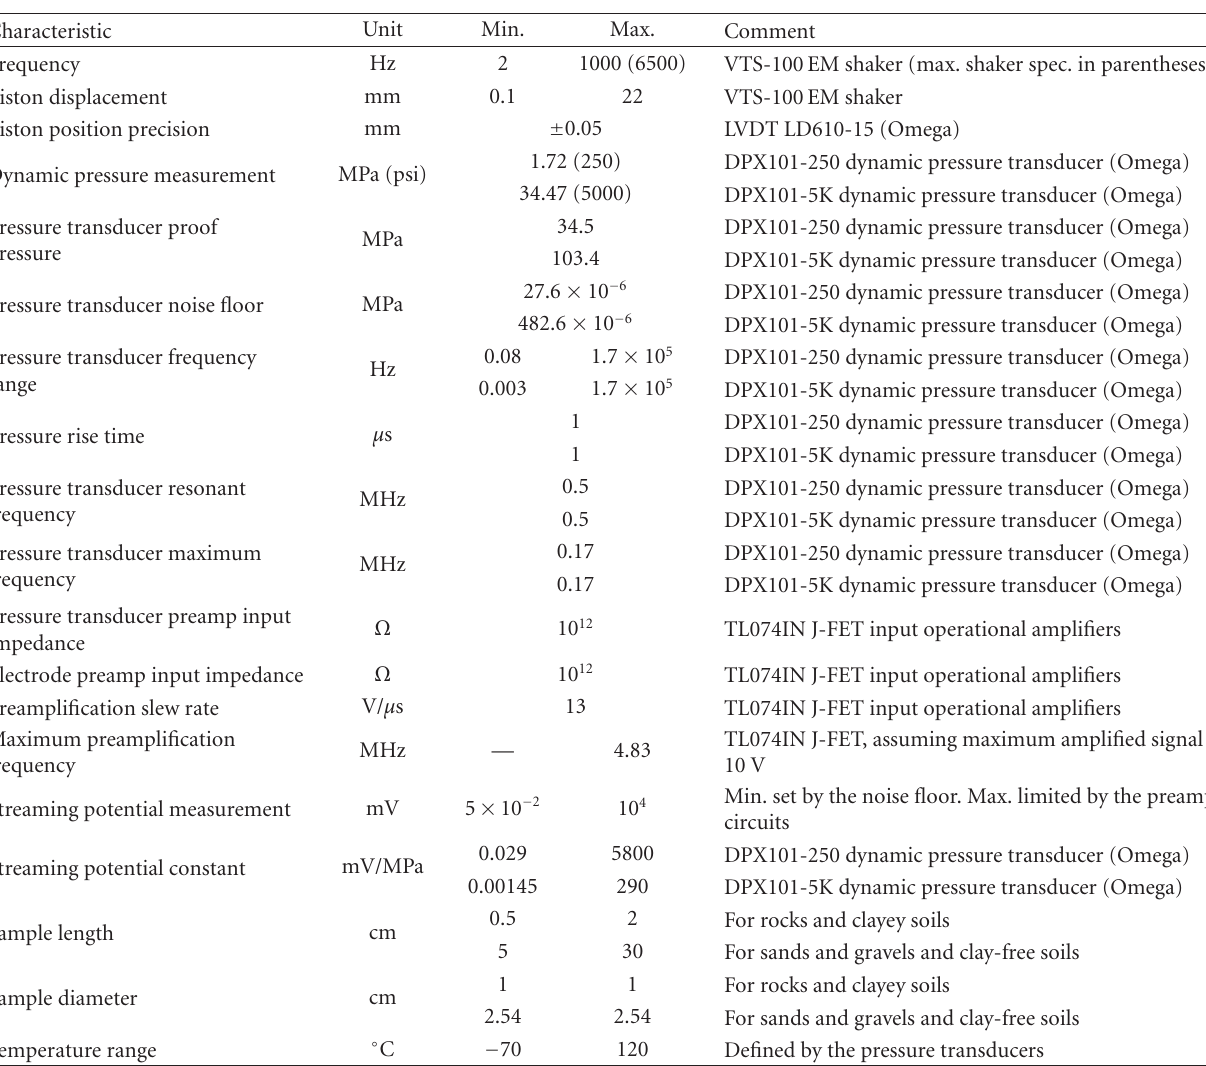
Table 1: Specifications of an apparatus for making frequency-dependent streaming potential coe ffi cient measurements.